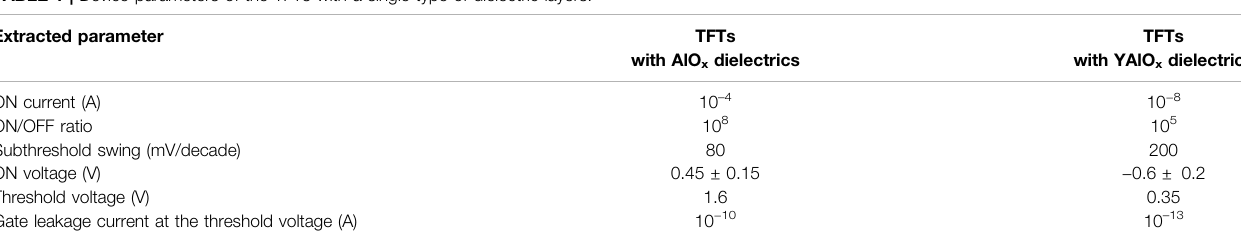
( Figure 1C ). The full sweep of the transfer characteristics of the YAlO x employing devices instead reveals clockwise hysteresis ( Figure 1D ). Clockwise hysteresis results from negative charge trapping within the dielectric and/or in the dielectric semiconductor interface (Cross and De Souza, 2006). The trapped negative charges screen the effect of the gate bias, and the accumulated channel region depletes at higher voltages than expected during the turn-off transient. A conclusion on these results is that, on the one hand, the gate stacks employing printed